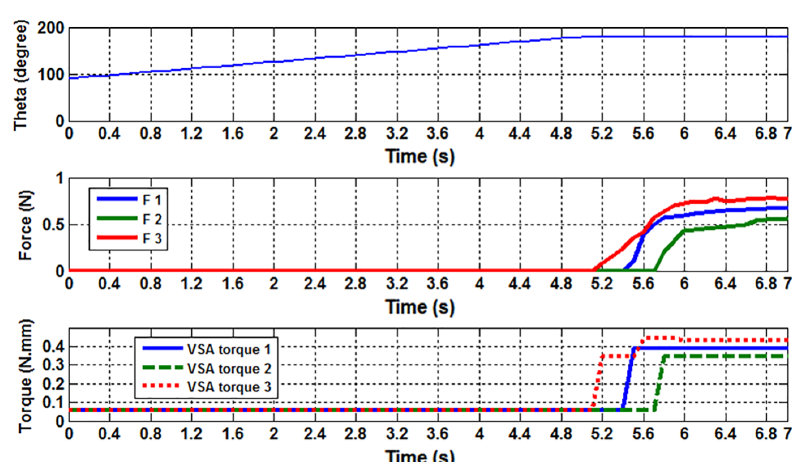
Figure 21. Hand grasping by CPRF.